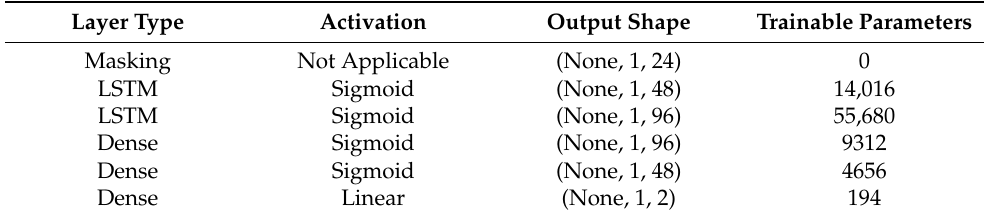
Table 3. Summary of network architecture for the joint associated fluid production